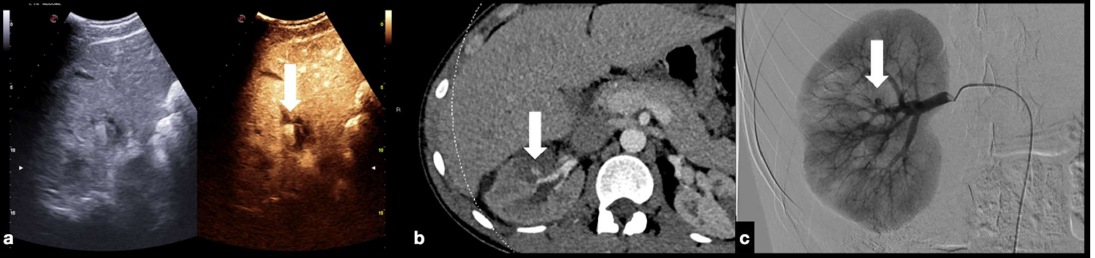
Figure 20. CEUS ( a ) of a 23−year-old man referring to the emergency department for direct blunt trauma to the right flank showed the presence of a small pseudoaneurysm (white arrow) inside the contusion area of the right kidney; the diagnosis was then confirmed at the axial arterial phase con- trast-enhanced CT scan ( b ) , as well as at angiography performed for treatment purposes ( c). Arteriovenous fistulas consist of traumatic communication between the arterial and venous systems [1,30]. Fistulas are characterized as asymmetrical, early contrast opacifi- cation of a vein during the early arterial phase of the study (Figure 21).